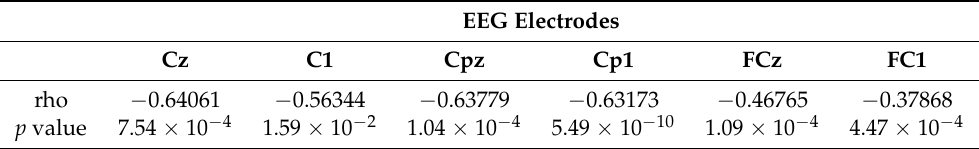
Figure 10. The time evaluation period of the ERD and hemodynamic response, oxyHb in the upper plot red line. ERD represented by the blue line in the lower plot. Table 1. Correlation coefficients of the alpha wave with oxyHb in the LPMCdr cortical area during right flexion